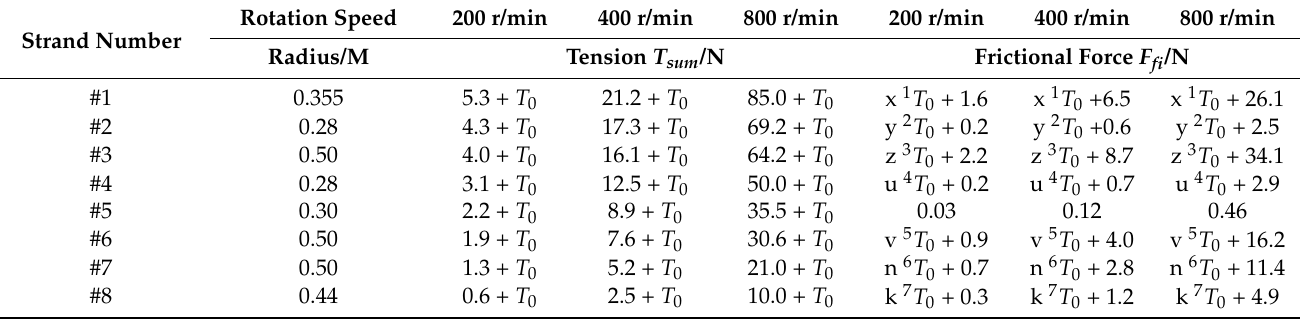
Table 2. Values of radius of gyration, tension, and frictional force for each strand at different speeds.